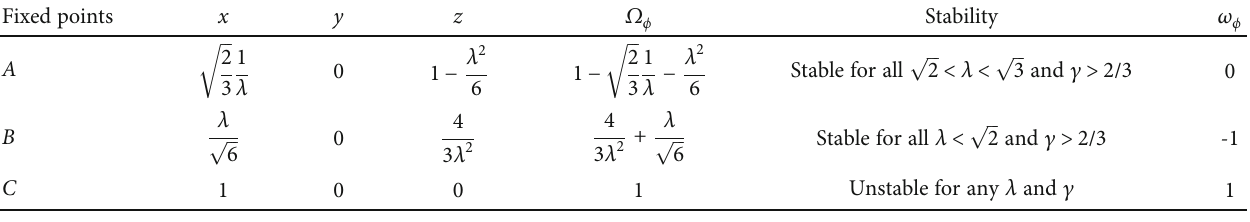
Figure 9: Shows the phase plot for the fi xed point R . Table 2: Table for dynamical system with simple exponential